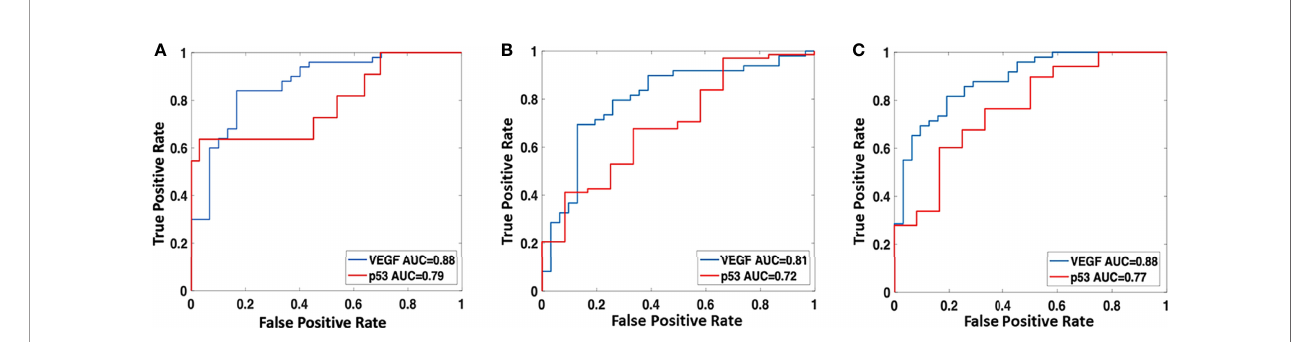
FIGURE 6 | The ROC curves were constructed by using the best models developed using (A) radiomics analysis; (B) clinical and imaging variables; and (C) combined radiomics scores and